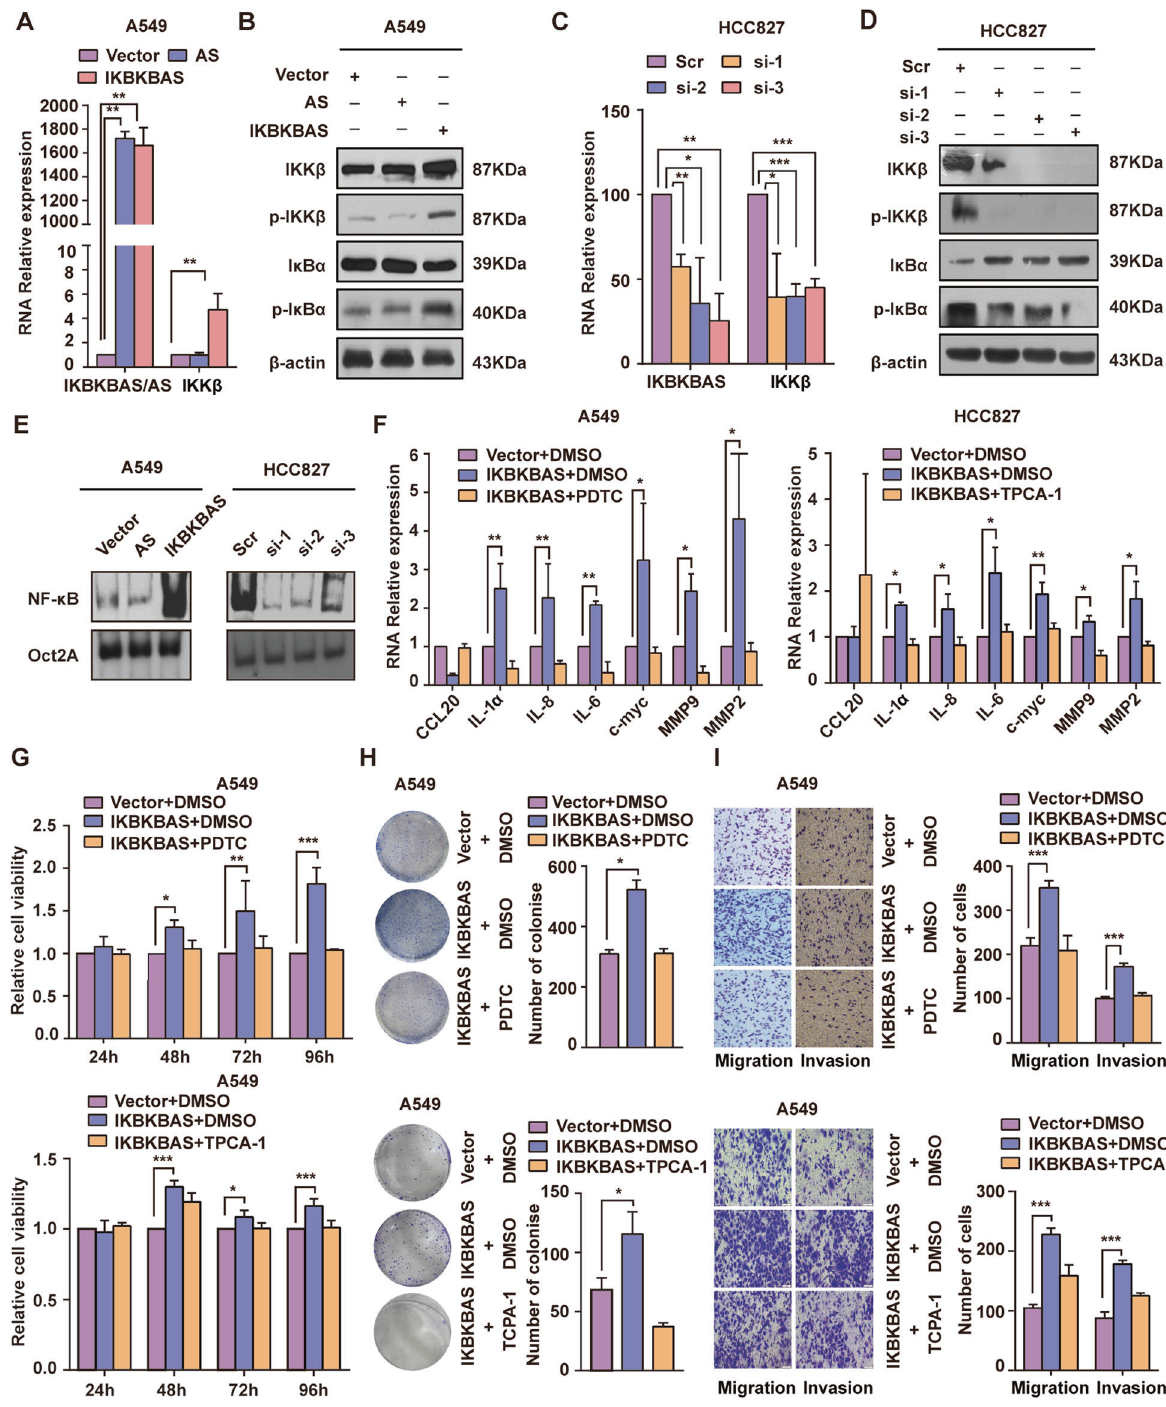
Fig. 3 IKBKBAS is a positive regulator of NF- κ B signaling pathway. A The relative expression of IKK β in A549 cells with ectopic expression of IKBKBAS were assayed by qRT-PCR. B Western blot analysis for the expression of IKK β , p-IKK β , I κ B α , and p-I κ B α in A549 cells with ectopic expression of IKBKBAS. C The relative expression of IKK β in HCC827 cells with knockdown of IKBKBAS assayed by qRT-PCR. D Western blot analysis for the expression of IKK β , p-IKK β , I κ B α , and p-I κ B α in HCC827 cells with knockdown of IKBKBAS. E Activity of NF- κ B in A549 cells with ectopic expression of IKBKBAS and activity of NF- κ B in HCC827 cells with knockdown of IKBKBAS were detected by EMSA. F The relative expression of target genes of NF- κ B were assayed by qRT-PCR in A549 cells, including IL-1 α /6/8, MMP9/2, c-myc, CCL20. The A549 cells were treated with ectopic expression of IKBKBAS, and with treatment of NF- κ B inhibitor PDTC and IKK β inhibitor TPCA-1, respectively. G MTT assay showing the effect of IKBKBAS on cell proliferation in A549 cells with PDTC or TPCA-1 treatment. H Plate colony formation assays showing the effect of IKBKBAS on colonizing ability in A549 cells with PDTC or TPCA-1 treatment. I Transwell assays exhibited the effect of IKBKBAS on invasion and migration ability in A549 cells with PDTC or TPCA-1 treatment.Data show mean ± SD, n ≥ 3, * P < 0.05, ** P < 0.01, *** P < 0.001. si-1: si-288; si-2: si-449; si3: si-288 + si-449.